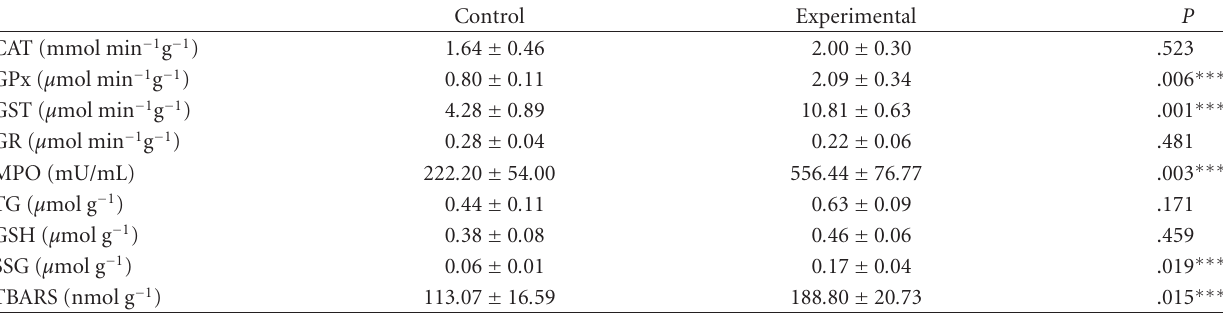
Table 1: Biomarkers of oxidative stress in gingival tissue of healthy control and individuals with periodontal disease. The results are repre- sented by means ± SEM of controls (healthy individuals) and patients with periodontal diseases (E). CAT = Activities of Catalase, GPx = glutathione peroxidase, GST = glutathione S-transferase, GR = glutathione reductase, MPO = myeloperoxidase, TG = total glutathione, GSH =